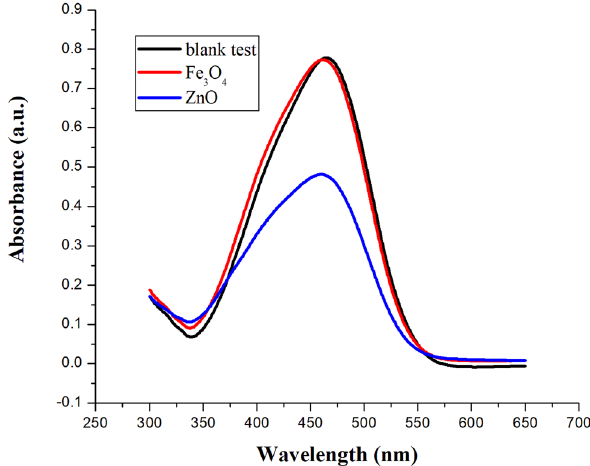
Figure 8: UV - visible absorbance spectra of degraded MO - dye under sunlight irradiation for 45 min over pure ZnO and Fe 3 O 4